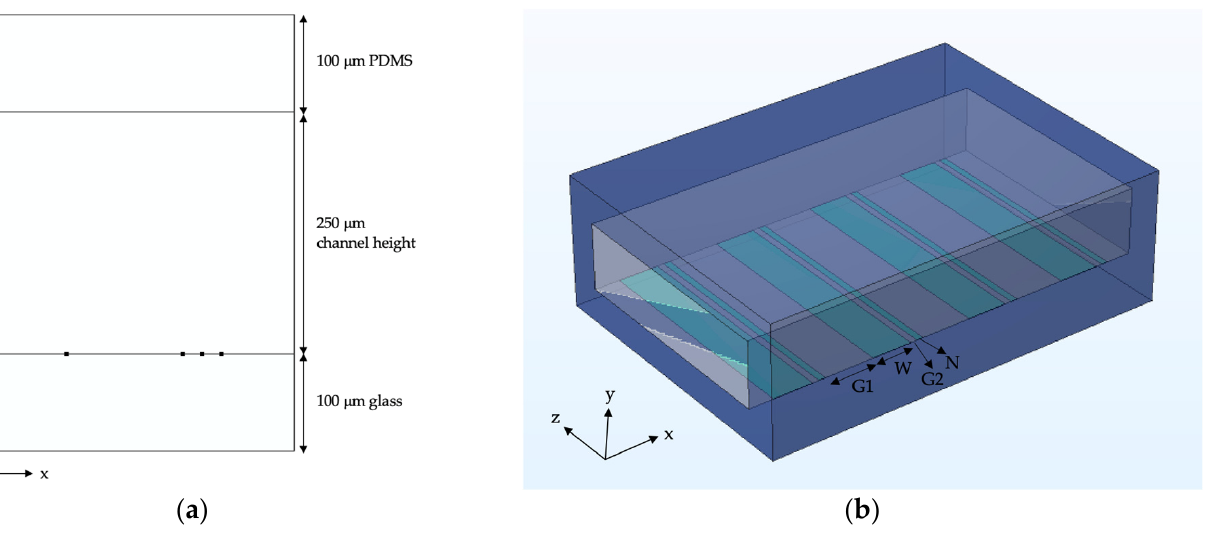
Figure 1. ACET micropump geometry used for COMSOL simulations. ( a ) depicts the cross-sectional geometry of the channel, with the square dots representing the electrode locations at the bottom of the channel and ( b ) shows a 3D model of the channel with electrode dimension definitions for gap 1 (G1), wide electrode (W), gap 2 (G2) and the narrow electrode (N). The x-y-z directions are added for reference in ( a , b ), where the z-direction points into the page in ( a ).